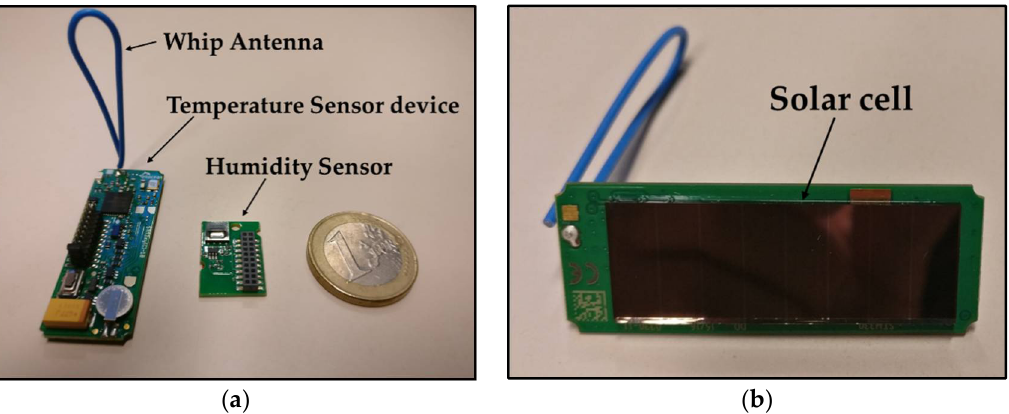
Figure 2. ( a ) EnOcean’s STM 330 module and the includable humidity sensor; ( b ) Detail of the STM 330 module’s solar cell.